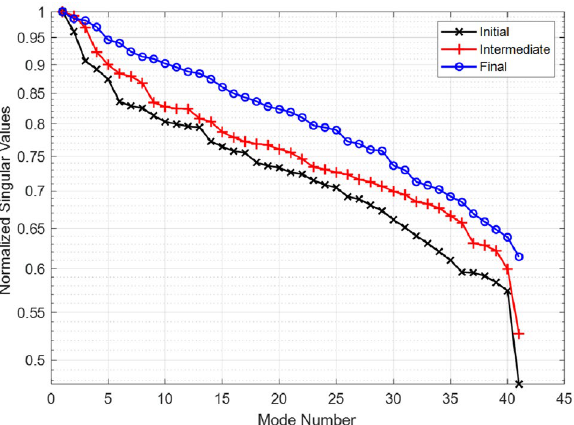
Figure 8. Singular value comparison between initial, intermediate and final optimized states of the lens-loaded cavity.